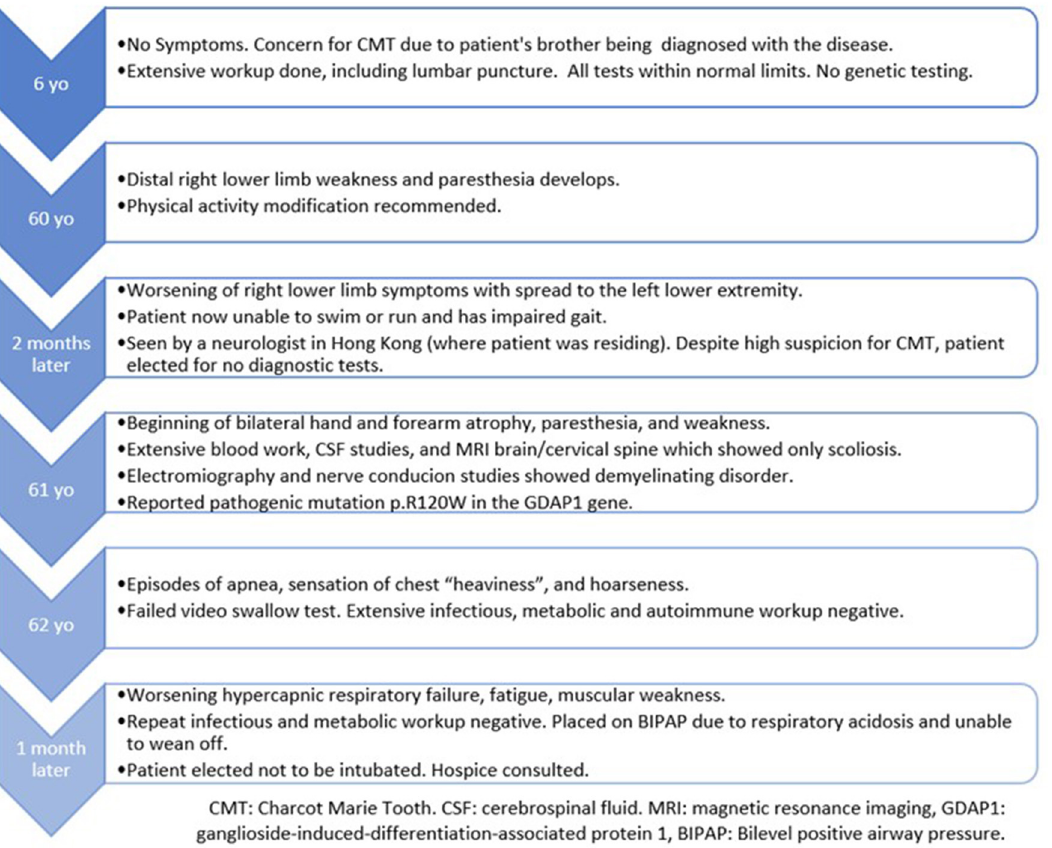
TABLE 2 Chronological clinical course of the